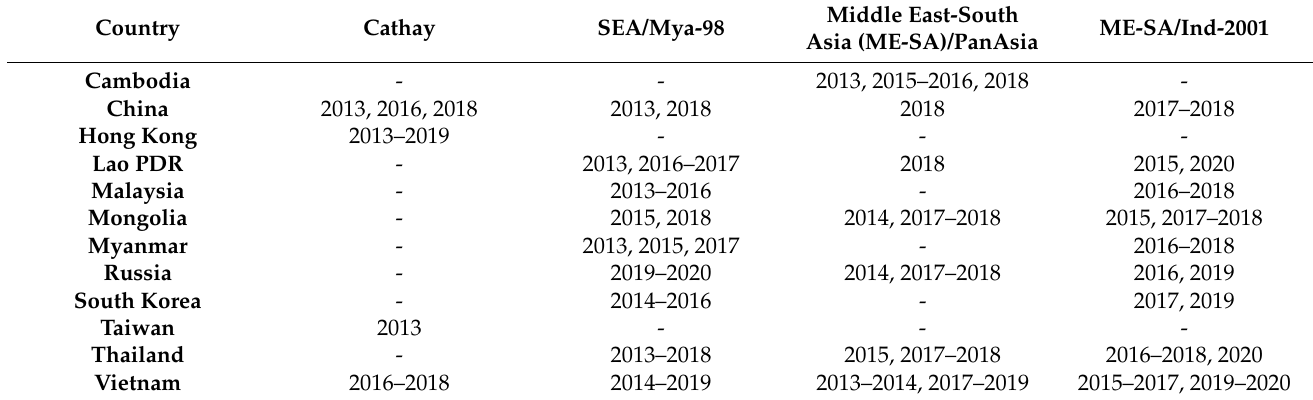
Table 1. List of serotype O foot and mouth disease virus (FMDV) strains detected in various Southeast Asia (SEA), East Asia (EA) and neighboring countries during